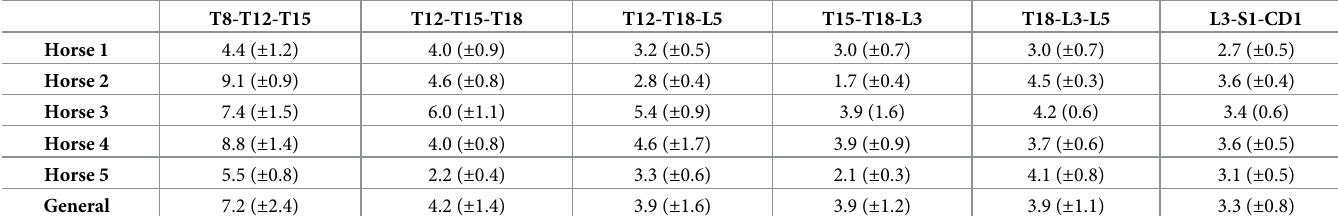
General T8-T12-T15 = markers affixed in the 8th, 12th and 15th thoracic vertebrae; T12-T15-T18 = markers affixed in the 12th, 15th and 18th thoracic vertebrae; T12-T18-L5 = markers affixed in the 12th and 15th thoracic vertebrae and 5th lumbar vertebra; T15-T18-L3 = markers affixed in the 15th and 18th thoracic vertebrae and 3rd lumbar vertebra; T18-L3-L5 = markers affixed in the 18th thoracic vertebra and 3rd and 5th lumbar vertebrae; L3-S1-CD1 = markers affixed in the 3rd lumbar vertebra, 1st sacral vertebra and 1st coccygeal vertebra.